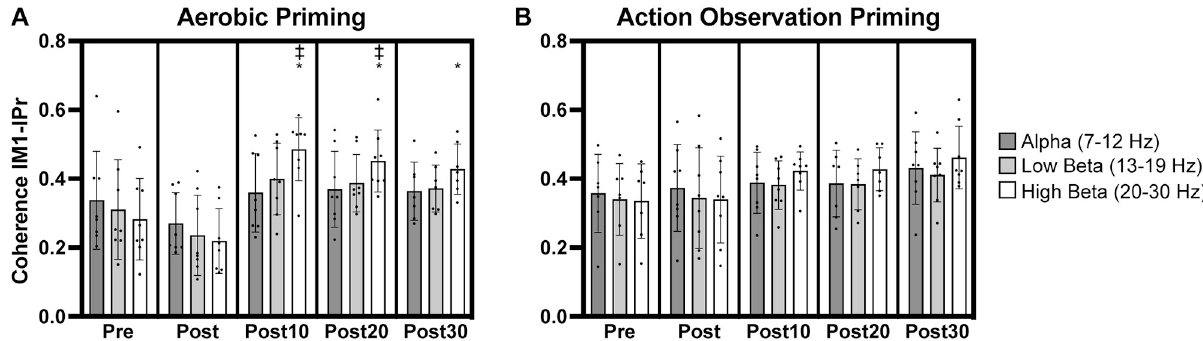
Fig 4. Coherence in leads overlying left primary motor (lM1) and left parietal (lPr) cortices. Increases in high beta lM1-lPr coherence occurred after aerobic priming (A). ‡ indicates significant change from pre timepoint. * indicates significant increase from post timepoint. https://doi.org/10.1371/journal.pone.0283975.g004 and group-level coherence measurements between leads overlying lM1 and SMA (Fig 3), lPr (Fig 4), rM1 (Fig 5), and lPMd (Fig 6) for aerobic exercise and action observation priming across all timepoints and frequencies. Additional group-level coherence information is pro- vided in the S2–S4 Tables.